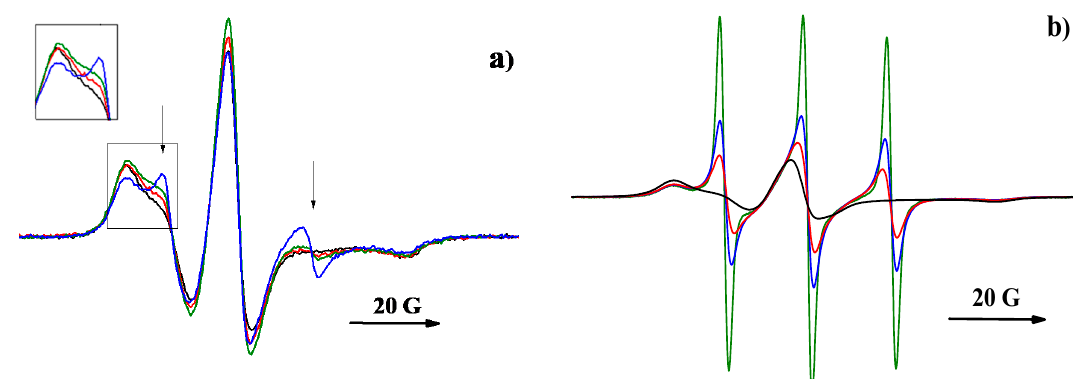
Figure 7. The EPR spectra of TEMPOL in PDL 02 film recorded at various holding times of the sample in solution: ( a ) dry sample (black line), 30 min (red line), 1 h (green line), and 6 h (blue line); ( b ) dry sample (black line), 2 days (red line), 7 days (blue line), and 17 days (green line).